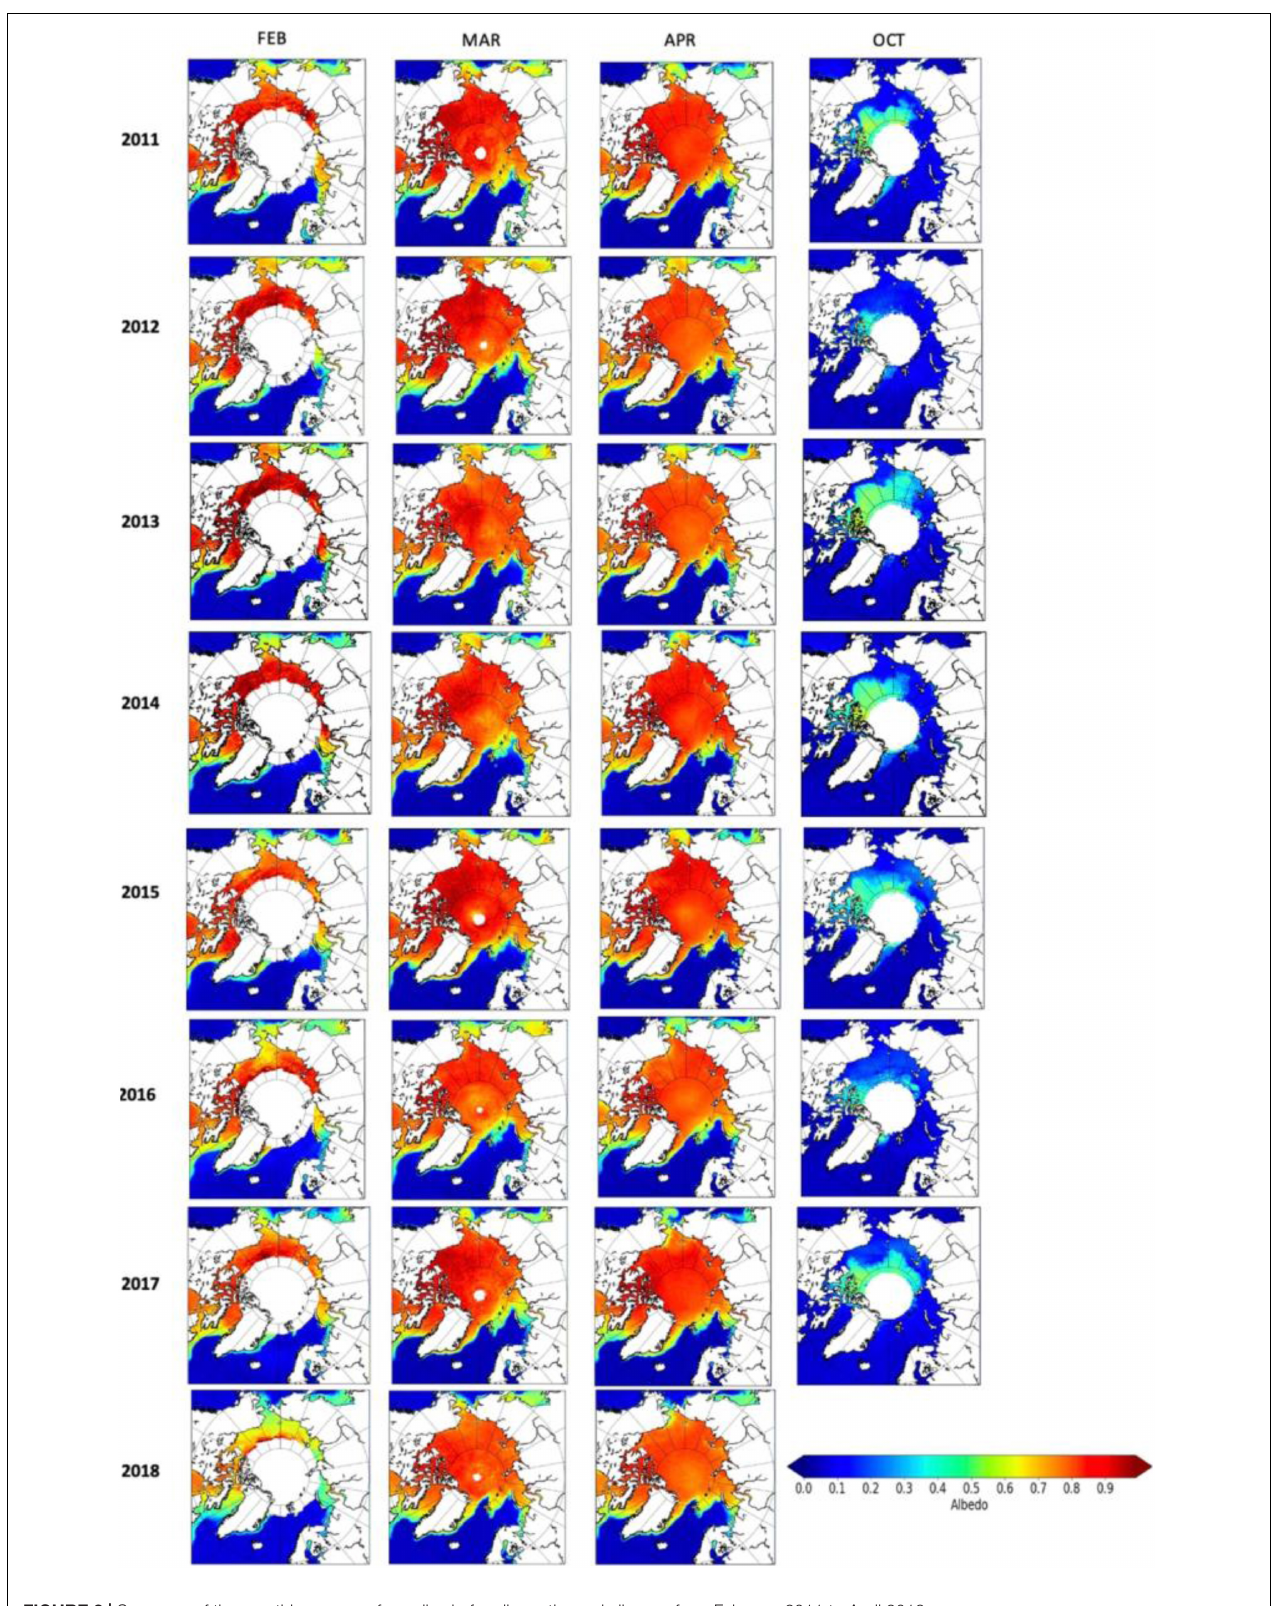
FIGURE 8 | Summary of the monthly mean surface albedo for all months and all years from February 2011 to April 2018.